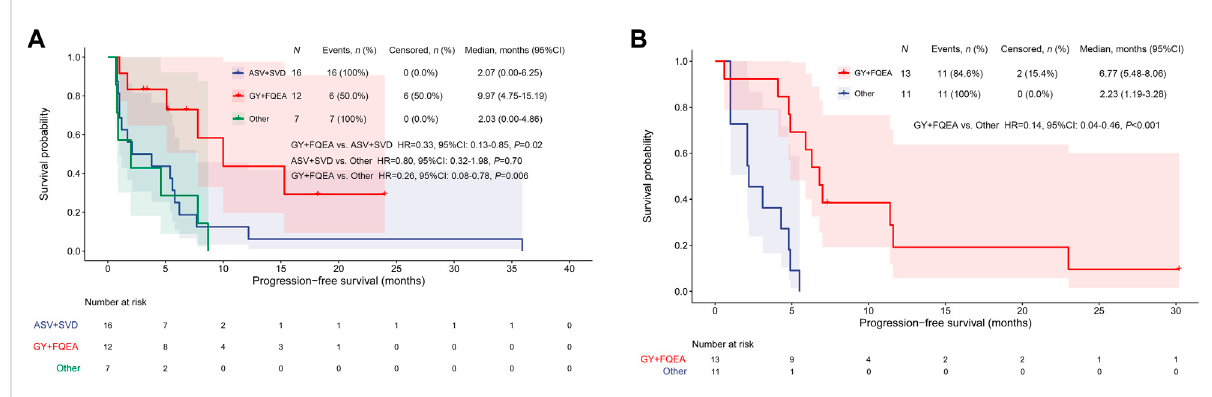
FIGURE 1 Kaplan – Meier curves for PFS by EGFR TKI targeted therapy among different ex20ins patients in the fi rst-line (A) and second-line setting (B)